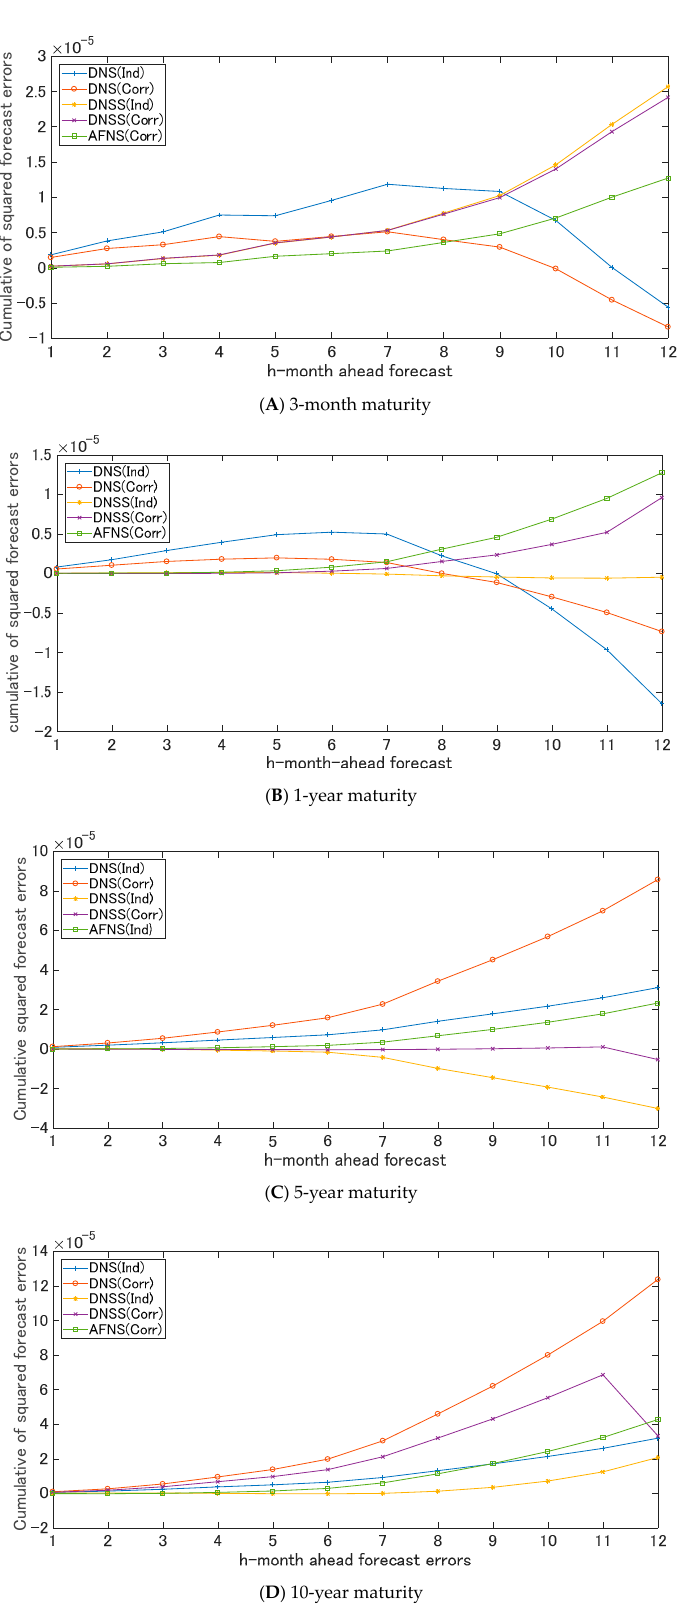
Figure 4. Cumulative of the squared forecast errors. Note: Figure 5 shows the cumulative of the squared errors of the forecasting of the JGB yields of the 3-month, 1-, 5-, and 10-year maturity. The cumulative of the squared forecast errors imply that the upward (downward) trend in the plot suggest that the models are inferior (superior) to the benchmark model (the random walk model).